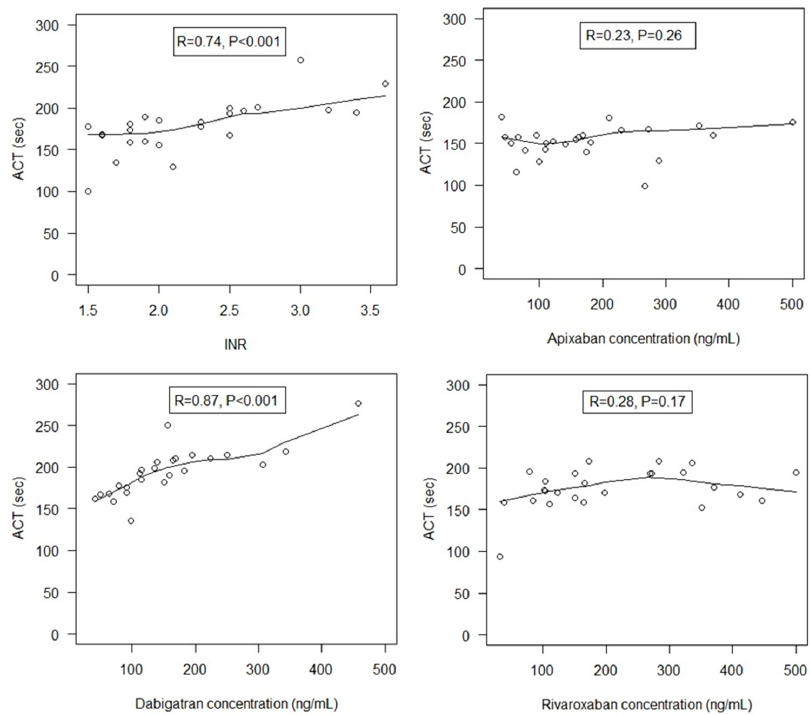
Figure 1. Relationship between activated clotting time (ACT) at baseline and direct oral anticoagulant (DOAC) concentration or International Normalized Ratio (INR). R represents the Spearman’s rank correlation coe ffi cients in each oral anticoagulant group (apixaban, rivaroxaban, dabigatran, and